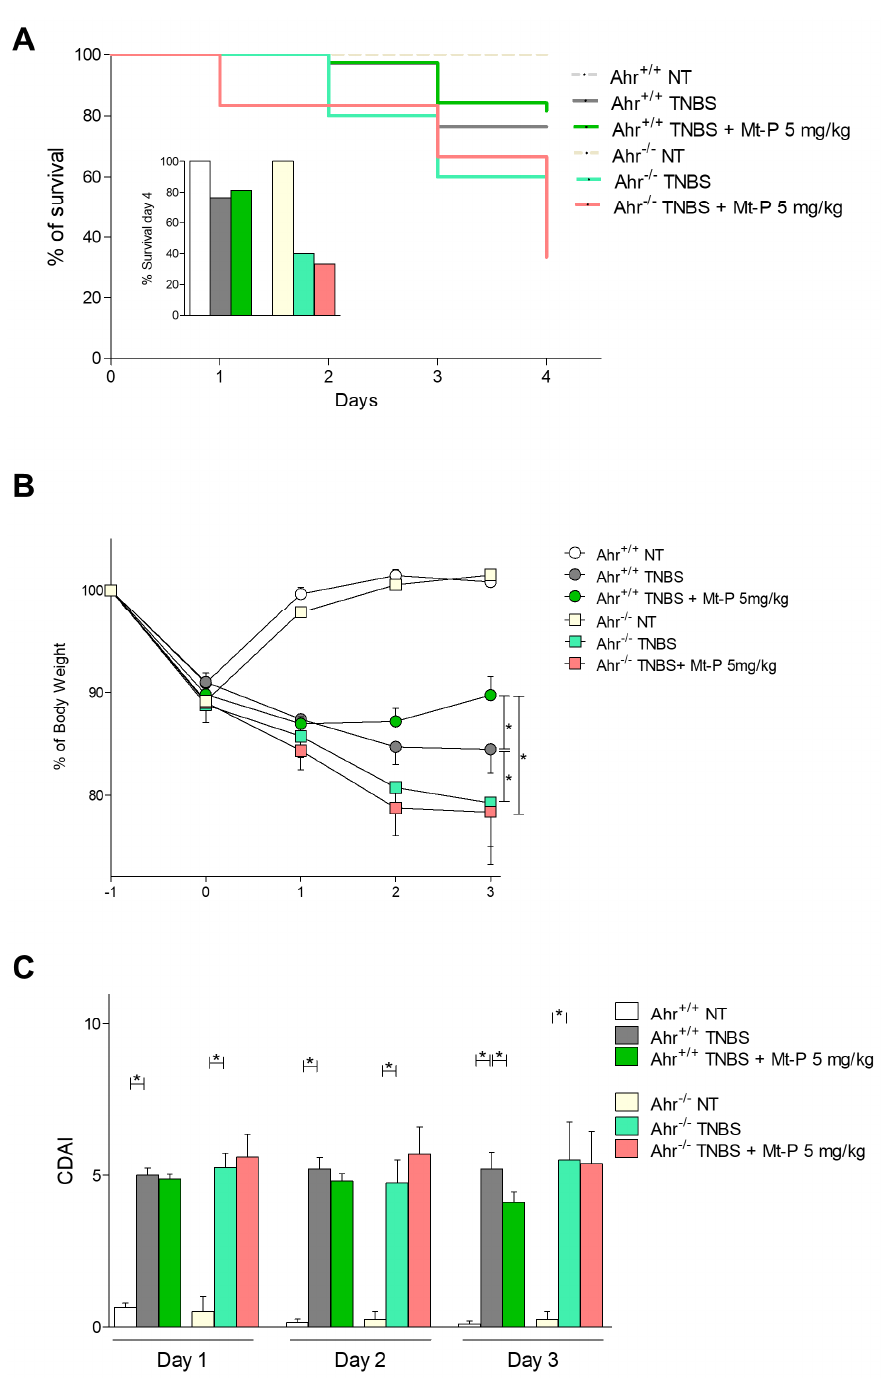
Figure 7. The beneficial effect of Mt-P is lost in AhR −/− mice. AhR +/+ and AhR −/− mice were treated with 1 mg of TNBS and then administered vehicle or Mt-P (5 mg/kg/d) by gavage from days 0 to 4. Treatment with Mt-P attenuated the development of disease only in AhR +/+ mice, on the contrary AhR gene ablation aggravated the disease. The disease was monitored by ( A ) percentage of survival, ( B ) changes in body weight, and ( C ) CDAI score. Results are the mean ± SEM of five/twelve mice per group (Ahr +/+ NT = 8; Ahr +/+ TNBS = 10; Ahr +/+ TNBS + Mt-P 5 mg/kg = 12; Ahr −/− NT = 5; Ahr −/− TNBS = 5; Ahr −/− TNBS + Mt-P 5 mg/kg = 6) (* p < 0.05).